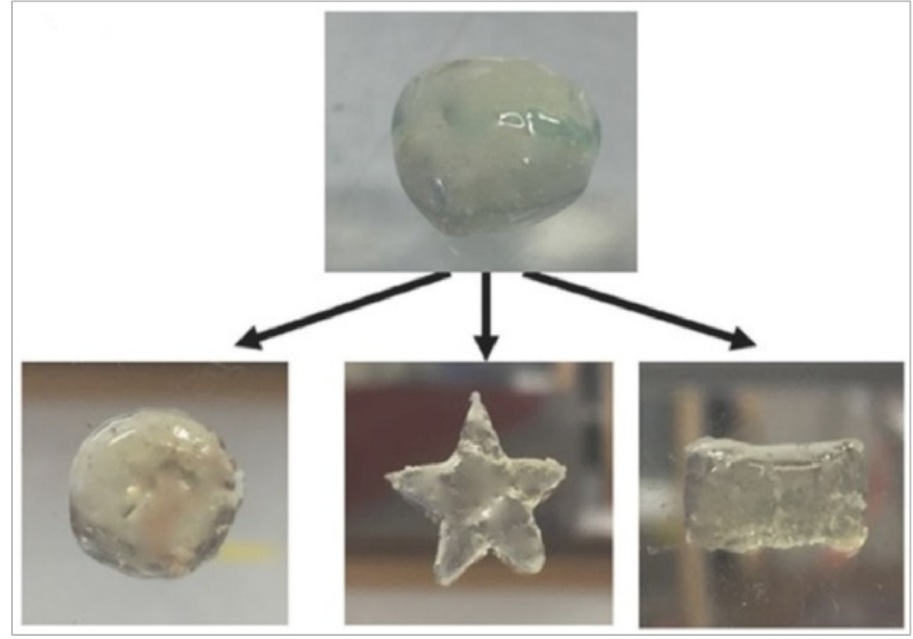
Figure 3. Example of HA-Ag NPs hydrogel and illustration of the possibility of its precise fitting to wounded site. Reprinted from Reference [33] with permission from John Wiley and Sons.